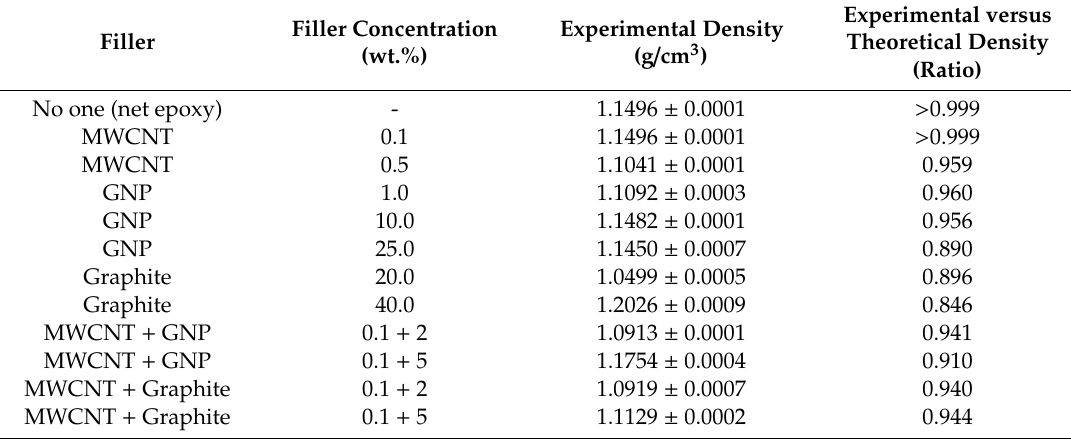
Table 2. Density of composites with di ff erent filler content.